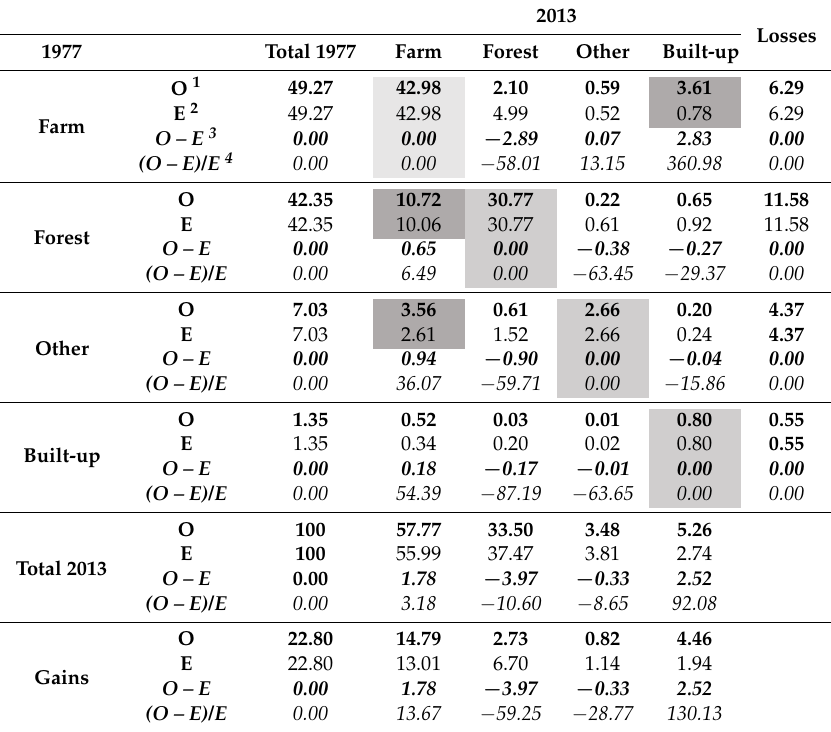
Table 2. Land-use changes over time with estimated losses for each